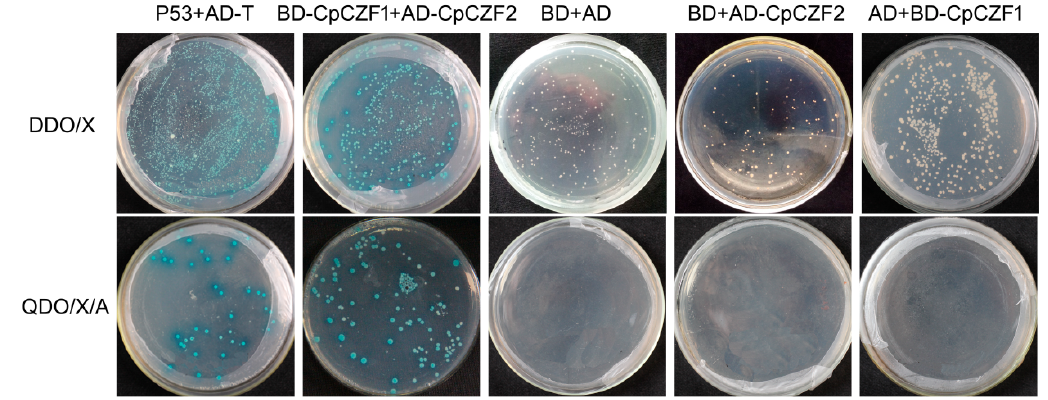
Figure 7. Yeast of two hybrids employed to detect the interactions of CpCZF1 and CpCZF2. Yeast cells co-transformed with BD-CpCZF1 and AD-CpCZF2 were spread onto selective media DDO/X and QDO/X/A to test the protein interactions. Yeast cells co-transformed with pGBKT7-53 ( BD-53 ) and pGADT7-T as the positive controls. Yeast cells co-transformed with BD and AD , BD and AD-CpCZF2 , and BD-CpCZF1 and AD as the negative controls. Selective media DDO/X was used to test the co-transformation efficiency; QDO/X/A media was used to test the positive interaction.